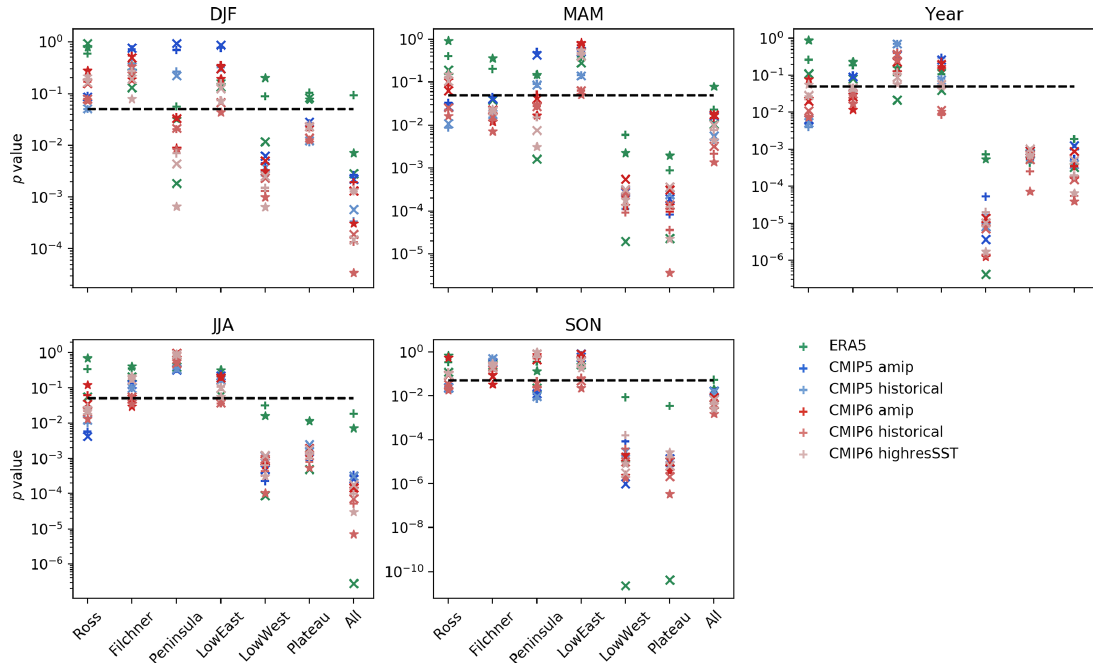
Figure D1. The p values of the Welch t test comparing the snowfall means from CloudSat to ERA5 and each of the CMIP (5 and 6) experiments for various seasons and the whole year in each of the regions considered. The black dashed line shows the 0 . 05 threshold to decide whether the hypothesis is rejected or not. “x” crosses indicate results considering the whole temporal coverage, “+” crosses the random 4 years, and stars the correct 4 years of the CloudSat climatology.